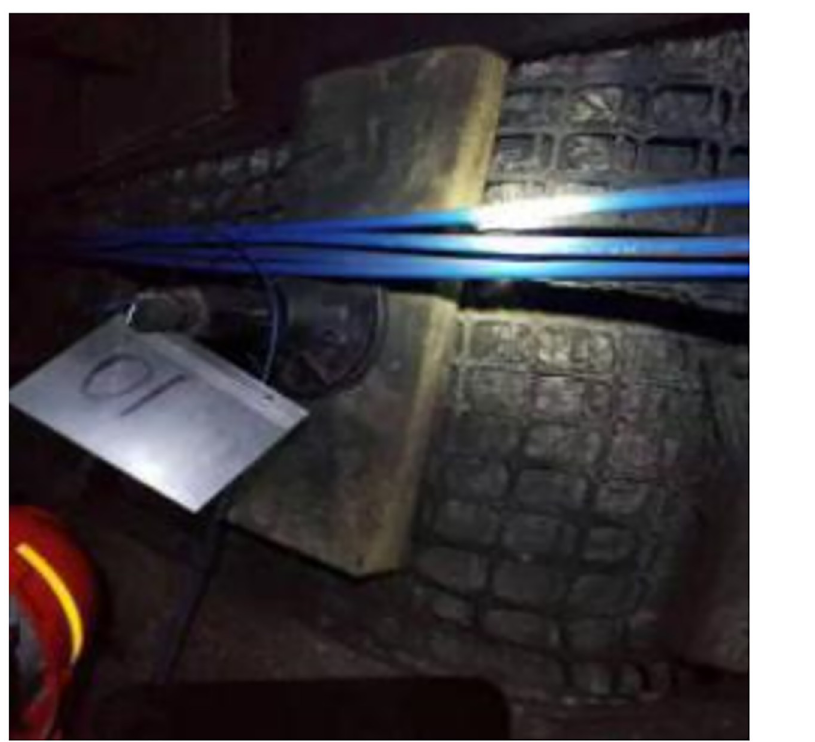
Fig 23. Another of pictures of monitoring of connection lines.